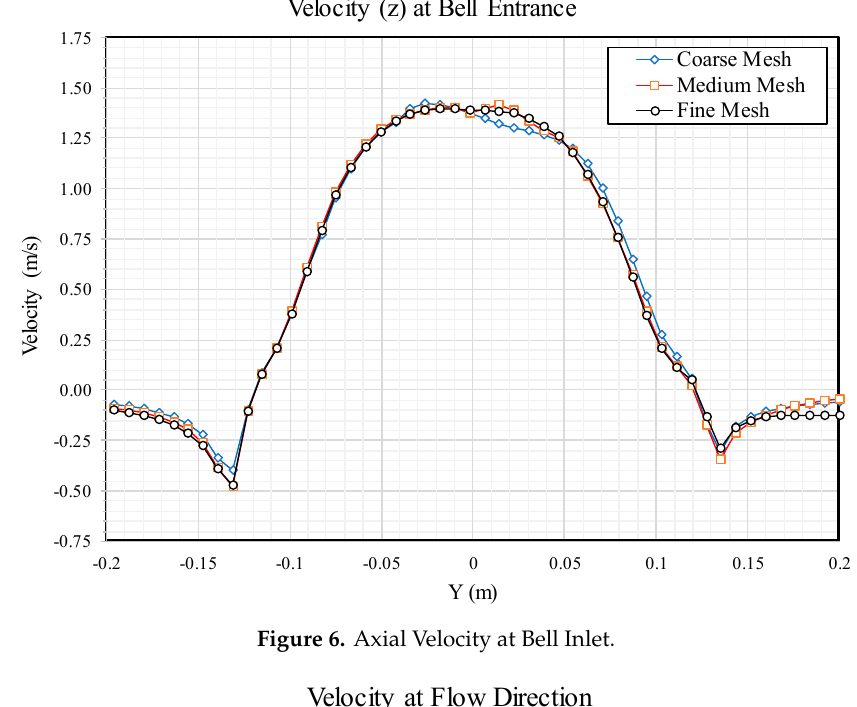
Figure 6. Axial Velocity at Bell Inlet.